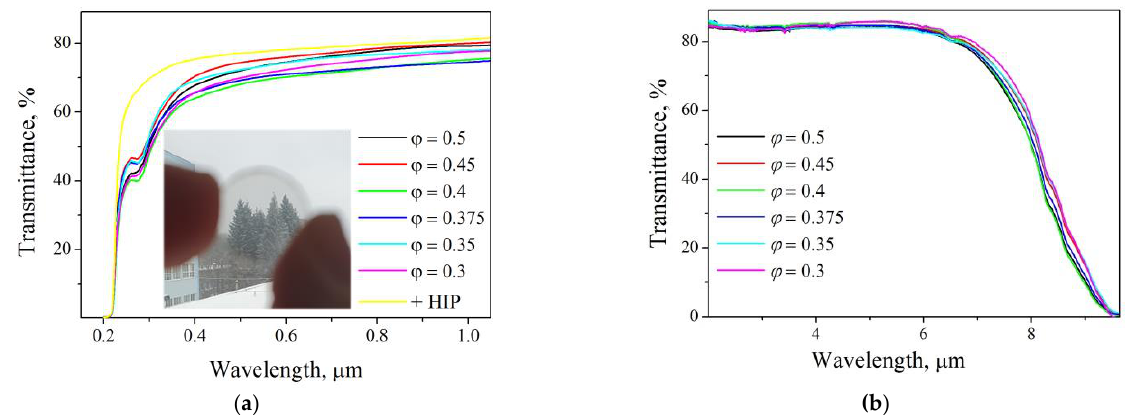
Figure 8. In-line transmission spectra of the Y 2 O 3 ceramics in the ( a ) visible and ( b ) infrared regions. Outside view seen through the HIPed ϕ = 0.45 ceramics and its transmission spectrum in the visible region are given for comparison.